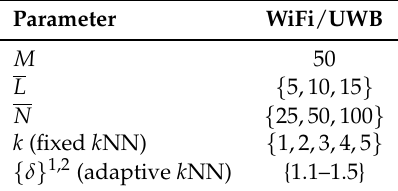
Table 1. Simulation parameters.